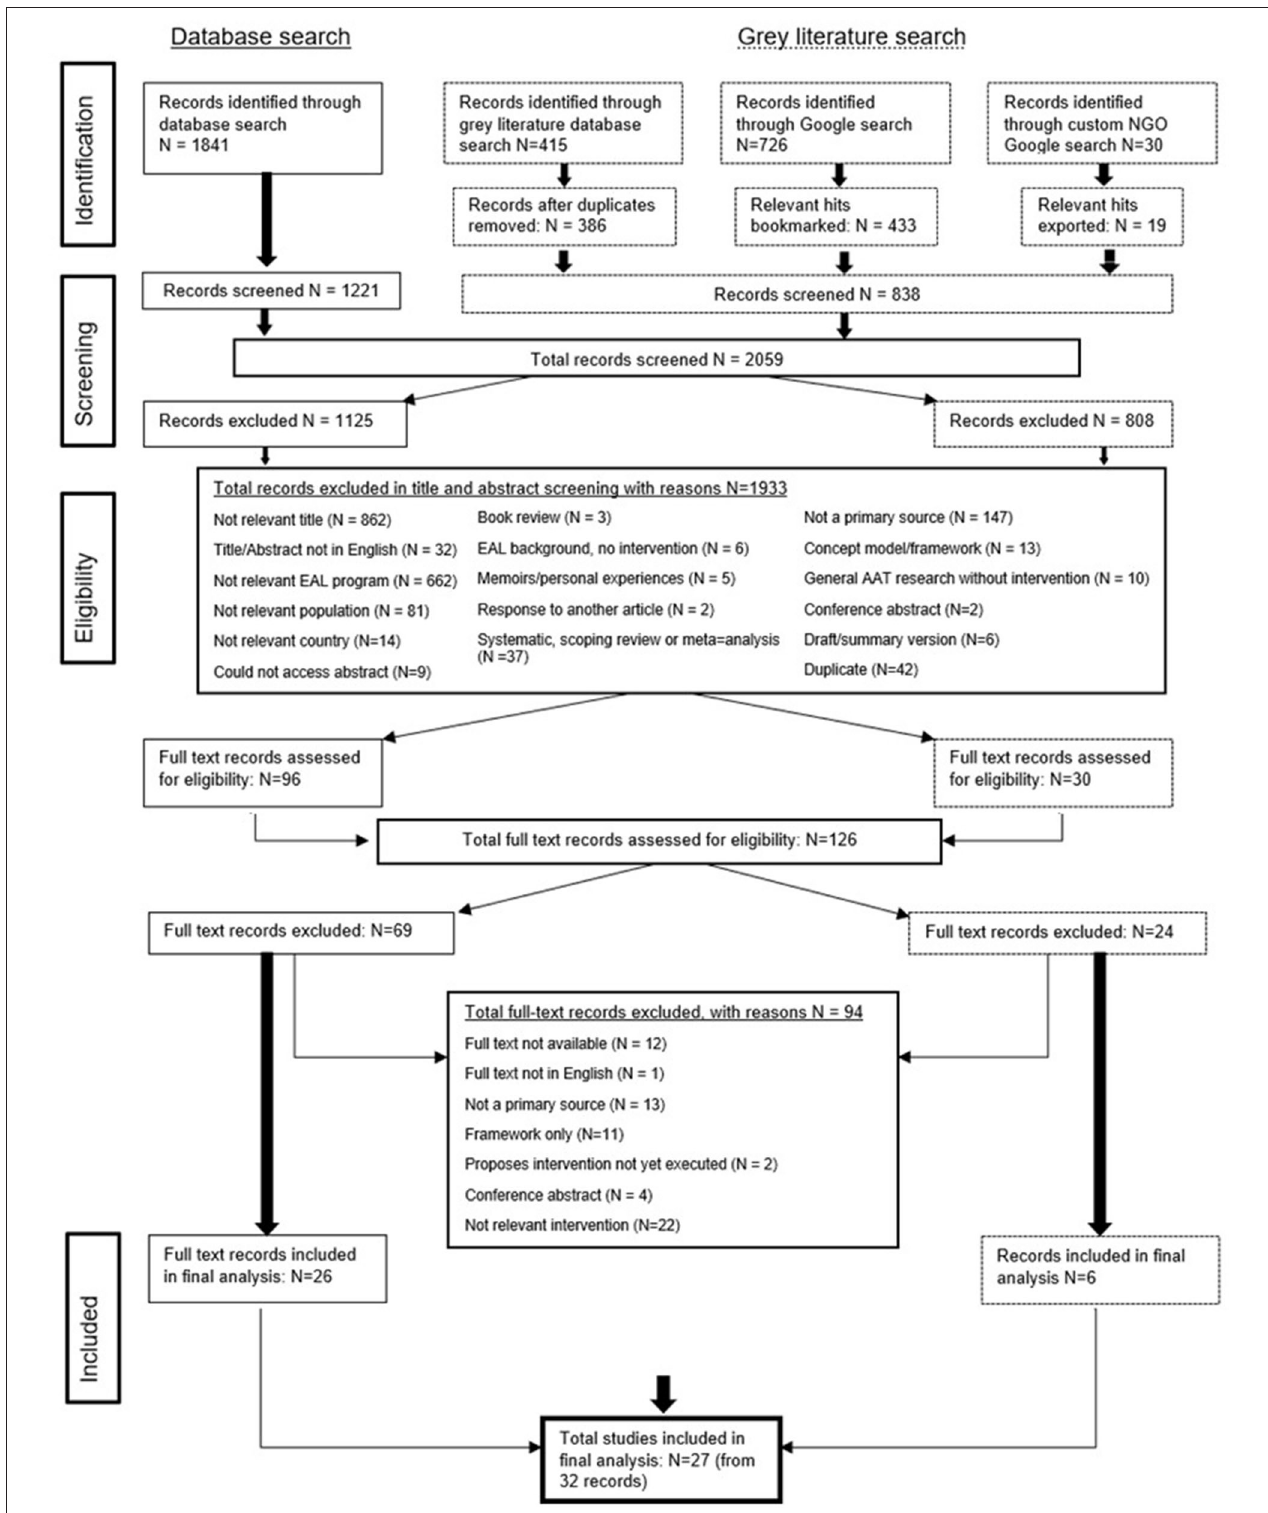
FIGURE 1 | PRISMA